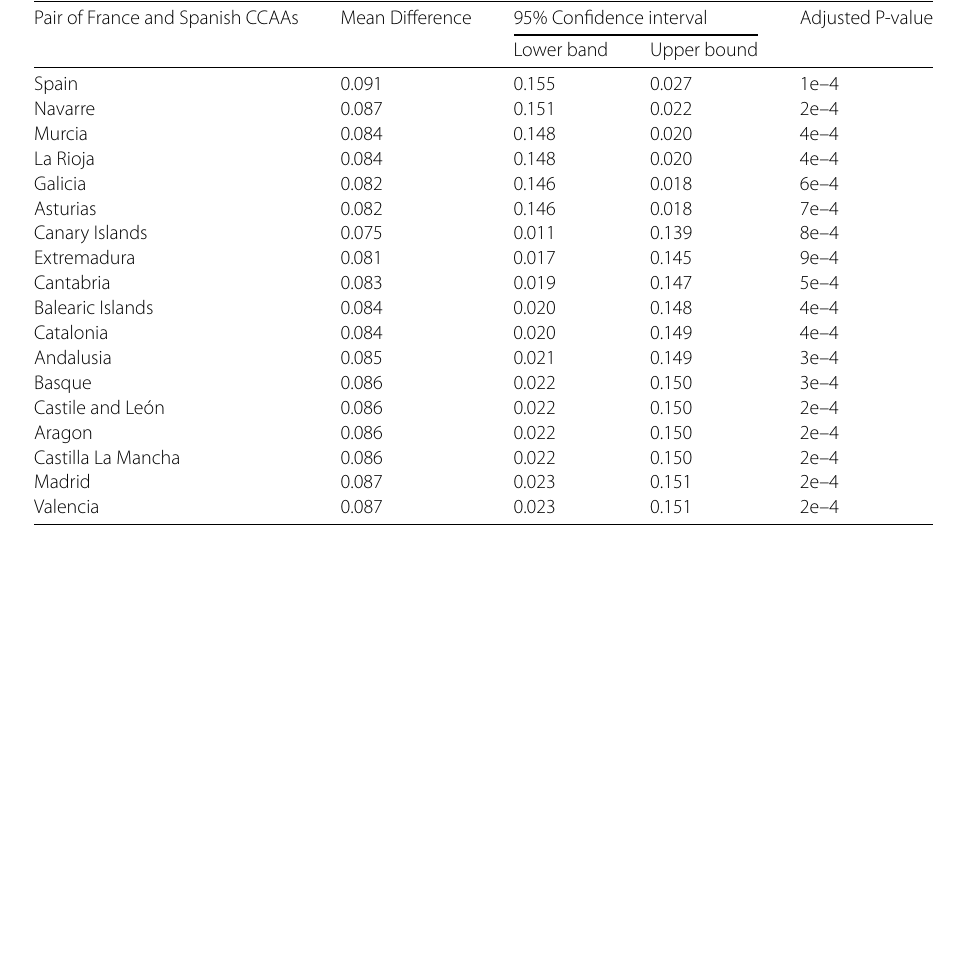
Table 10 HSD Tukey test results filtered by for the pair of CCAAs-countires which include Midi-Pyrenees Pair of close French province (Midi-Pyrenees) and Spanish CCAAs